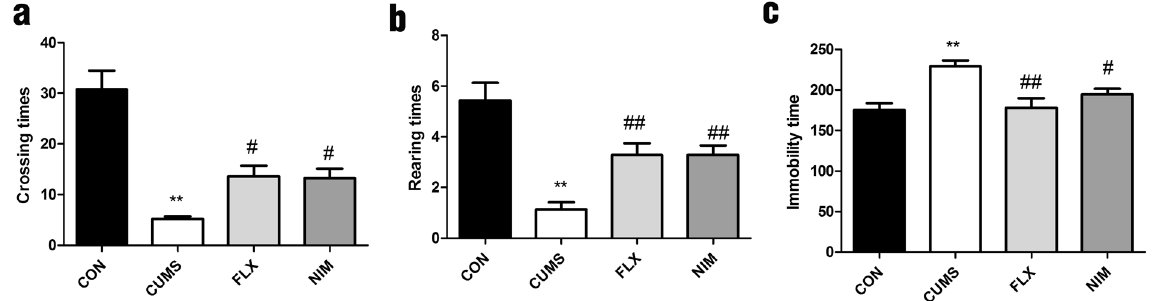
Figure 1. Effects of nimesulide on depressive-like behaviors in CUMS rats. ( a ) Nimesulide improved crossing times in CUMS rats. ( b ) Nimesulide improved rearing times in CUMS rats. ( c ) Nimesulide decreased immobility time in CUMS rats. All data are presented as mean ± SEM, n = 10 rats/group. ** p < 0.01 vs. CON; ## p < 0.01, # p < 0.05 vs. CUMS. One-way ANOVA followed by Dennett’s